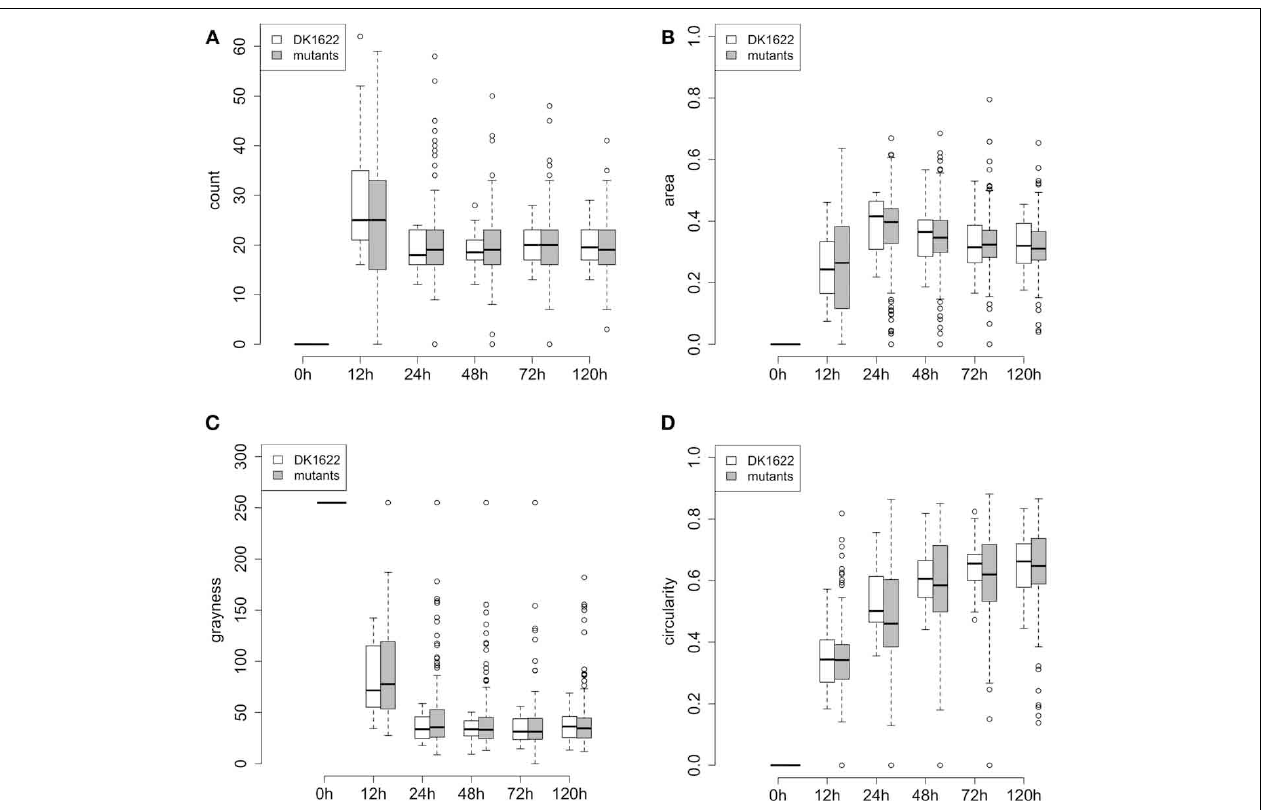
FIGURE 5 | Phenotypic traits of wild type and mutant aggregates during development (5 days). (A–D) Represent the quantitative traits for fruiting body development: (A) count, (B) area, (C) grayness, and (D) circularity. At each time point, the box represents the middle 50% of the